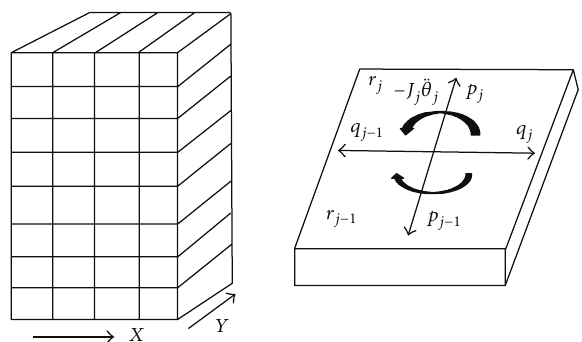
Figure5:Three-dimensionalbuildingstructureswithparametersof each